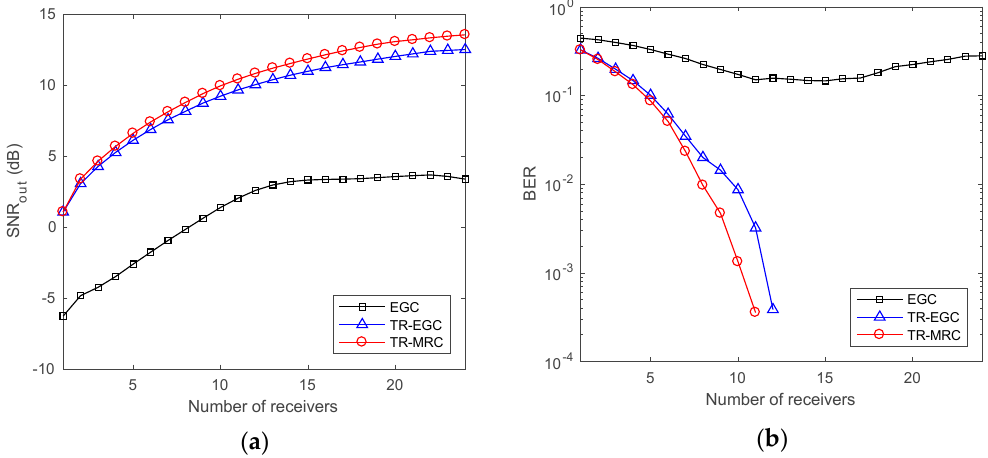
Figure 8. Performance of 80 km UWA communication as a function of the number of receivers. ( a ) Output SNR; ( b ) BER.